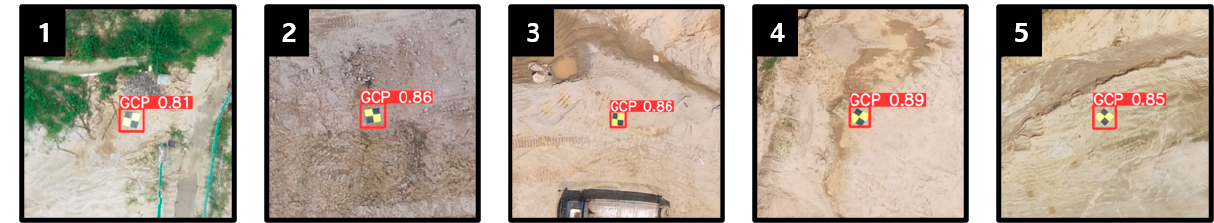
Figure 10. Detection results of five GCPs in orthophoto of Data 1.